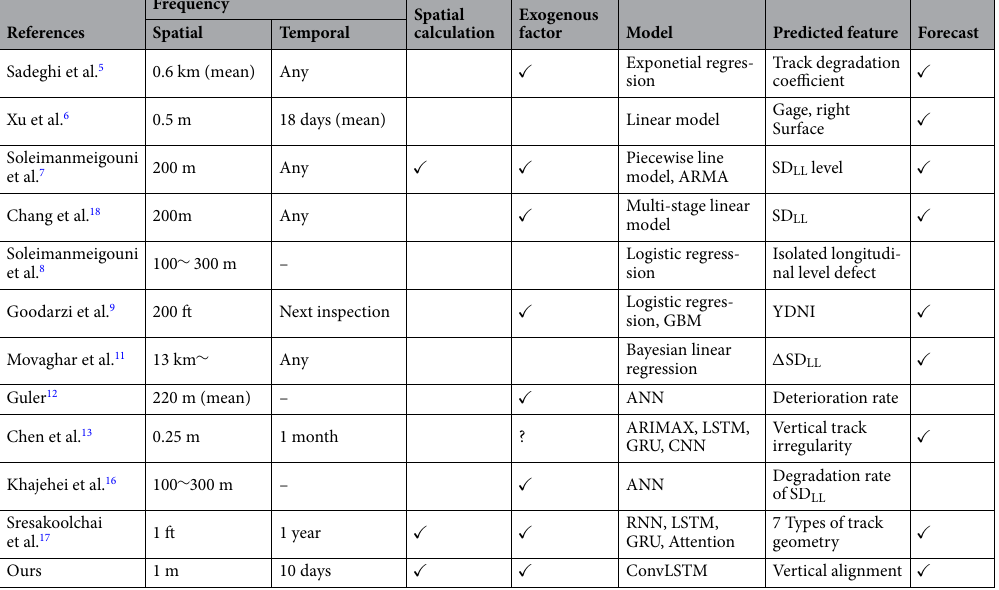
a model with reversibility (the ARMA model) because spatial relationships have a two-directional dependence. The ARMA model computes only the spatial correlations in the initial state. In contrast, the proposed model computes spatial correlations for the degradation process. Maintenance and other exogenous factors have a spatial effect on track geometry irregularities, particularly because of the chord offset method. The spatial measure- ment interval of the aforementioned ARMA model is 200[m] and the corresponding spatial frequency is lower than that of our method. Notably, the ARMA model allowed for any temporal frequency as time was included as an independent variable. Chang et al. use a multi-stage linear model to forecast SD LL , the standard deviation of the longitudinal level (same as the vertical alignment) between two maintenance. They use the total passing tonnage from last maintenance as explanatory variable. Soleimanmeigouni et al. 8 used logistic regression to predict the occurrence of longitudinal isolated defects, which are short irregularities in the track geometry. We forecast vertical alignment with high spatial frequency to detect local defects. In Tokaido Shinkansen, the railroad operators focus on preventive monitoring and repair of local defects for safety. Goodarzi et al. 9 also used logistic regression and gradient boost machine (GBM) to predict yellow-tag defects at the next inspection (YDNI). A yellow-tag defect indicates that the track geometry will soon become a red-tag defect. The red-tag defect indicates that the track geometry violates the Federal Railroad Administration (FRA) track safety standards and must be corrected as soon as possible 10 . They use the train load in million gross tonnes (MGT), track class, and ballast fouling index (BFI) as input data. The result shows that the BFI improves the forecasting performance. This study uses the ballast age instead of the ballast deterioration. Movaghar and Mohammadzadeh 11 computed a Bayesian linear regression model with exogenous data as the independent variable and SD LL , the standard deviation of the longitudinal level (same as the vertical alignment), as the dependent variable. Their method was applied to each track section with track section lengths of 13, 23, 24, and 18 [km]. The spatial frequency of our method is higher than that of their method. Moreover, although the temporal frequency of their forecasting method is one year, it can forecast at any temporal frequency because the method includes time as an independent variable. Guler 12 uses artificial neural networks (ANNs) to predict the degradation rate of the track geometry irregu- larities between two maintenance works for each analytical segment (AS). The average length of AS is 220 m. They input exogenous data such as traffic loads and speed into the ANN. This study also uses the passing tonnage since the last inspection as exogenous data. Chen et al. 13 used long short-term memory (LSTM) 14 , gated recurrent units (GRU) 15 , CNNs, and their ensembles to forecast vertical track irregularities (same as vertical alignment) in time and spatial series. Their temporal measurement interval was one month, and the time frequency of the forecast was one year. Their spatial measurement interval was 0.5[m]. Their method does not include spatial computations in time-series forecasting, in contrast to our method, which includes spatial computations. Addi- tionally, the temporal frequency of our method is higher than theirs. Khajehei et al. 16 used ANN to predict the degradation rate of SD LL . They fed a variety of exogenous data into the model. They used the ballast age, the maintenance history, the level of degradation after tamping or renewal, the average annual frequency of trains, etc. They used the Garson method to investigate the relative importance of the variables affecting the rate of geometry degradation. They found that the maintenance history made the most significant contribution. This study also uses maintenance records as exogenous data. Sresakoolchai and Kaewunruen 17 used recurrent neural networks (RNN), LSTM, GRU, and an attention mechanism to forecast seven track geometry irregularities. They proposed a model that computes spatial relationships. However, the model only computes unidirectional